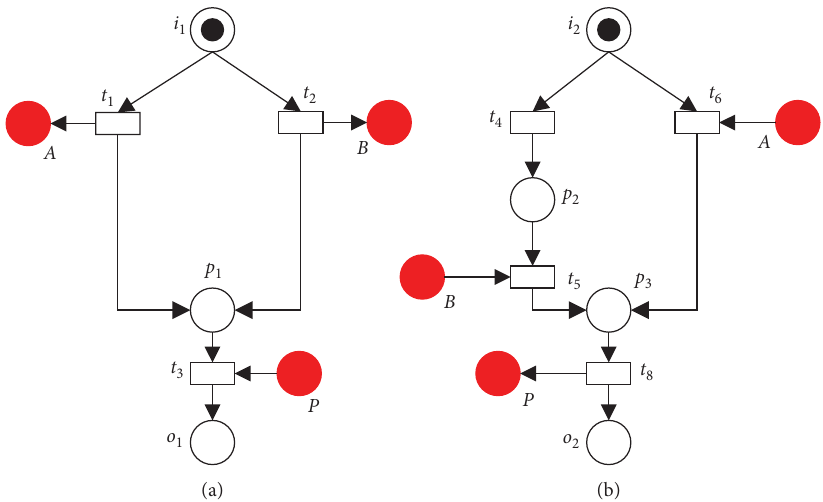
Figure 3: Open nets. (a) Open net N